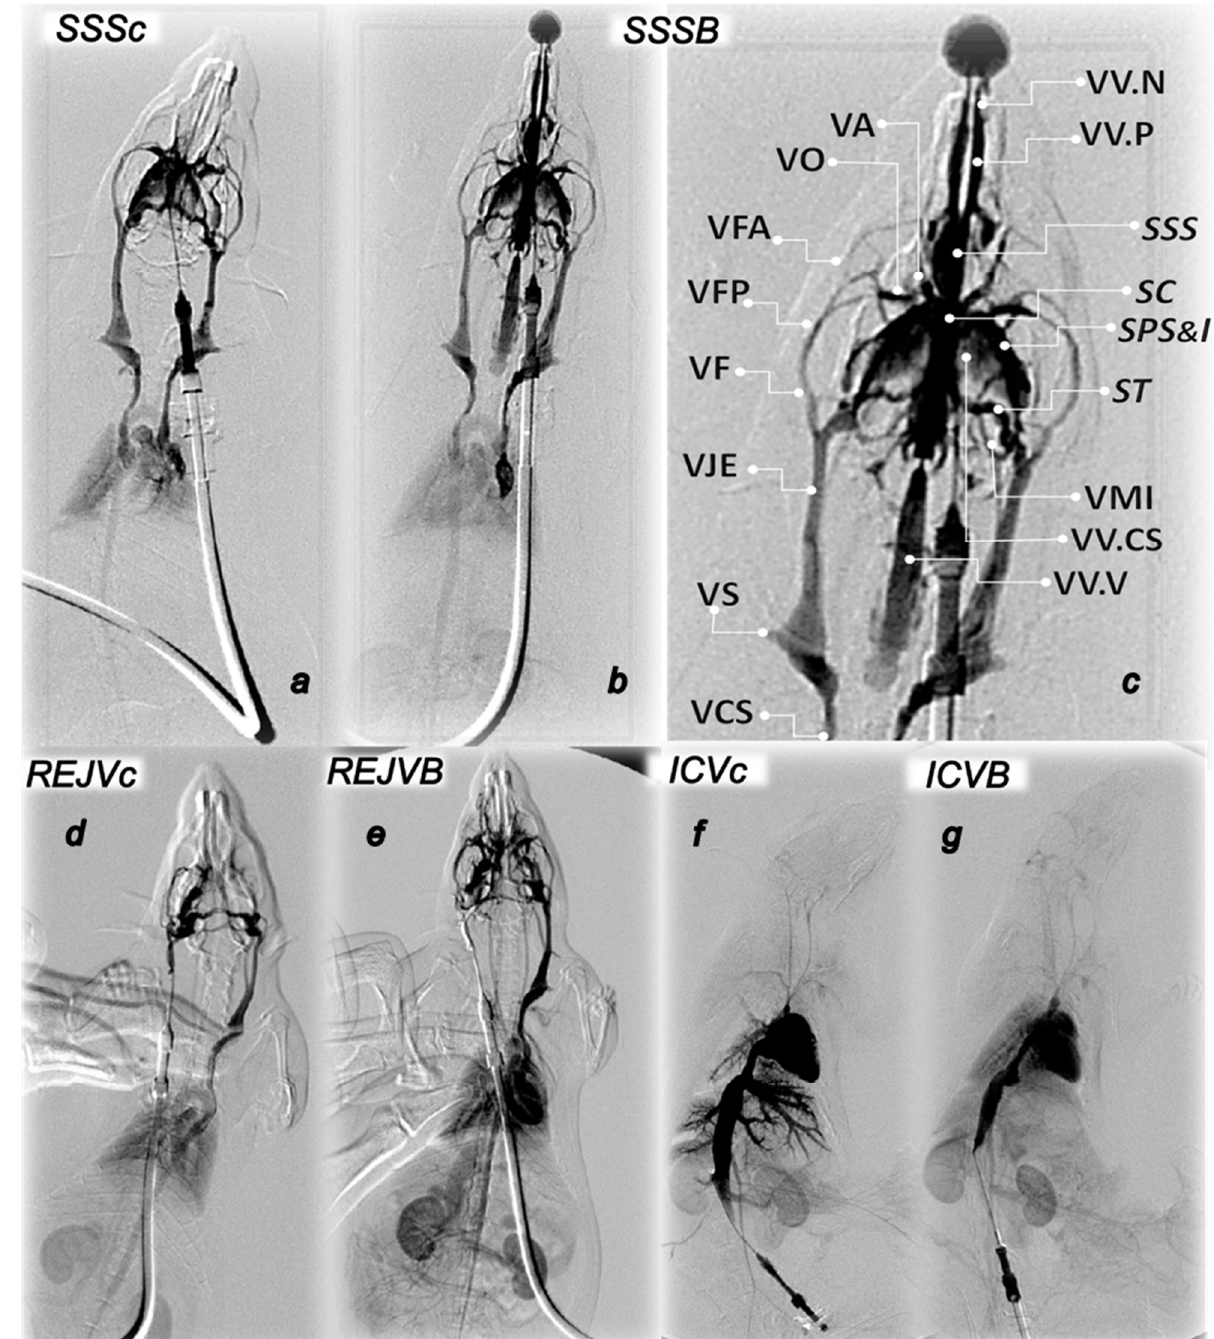
Figure 7. Along with saline ( c ) or BPC 167 ( B ) presentation of venography in superior sagittal sinus (SSS) ( a – c ), right external jugular vein (REJV) ( d , e ) and inferior caval vein (ICV) ( f , g ). SSS. Upper Left: Control venography in superior sagittal sinus ( SSSc ) ( a ). Retrograde filling of both jugular external veins and both superior caval veins. Pulmonary congestion with heart dilatation and without inflow of contrast media in the heart. Retrograde filling of pale inferior caval vein. Upper Right: BPC 157 venography in superior sagittal sinus ( SSSB ) ( b , c ). Retrograde filling of both jugular external veins and both superior caval veins with vertebral veins. There is no sign of pulmonary congestion and heart dilatation and with normal filling of contrast media in the heart. Retrograde filling of wider inferior caval vein with inflow of hepatic veins, both renal veins with parenchymal phase visualization of both kidneys and adrenals. Presentation of the pterigopalatinal veins (VVP) and nasal veins (VV.N) and presentation of the ophthalmic vein (VO), angularis vein (VA), facial anterior and posterior vein (VFA, VFP), and facial vein (VF), or through cerebri superior veins (VV.CS), sinus cavernosus (SC), sinus petrosus superior and inferior (SPS&I), sinus transversus (ST), through jugular external vein (VJE), subclavia vein (VS) through superior caval veins (VCS). Lower Left: REJV. Control venography through right external jugular vein